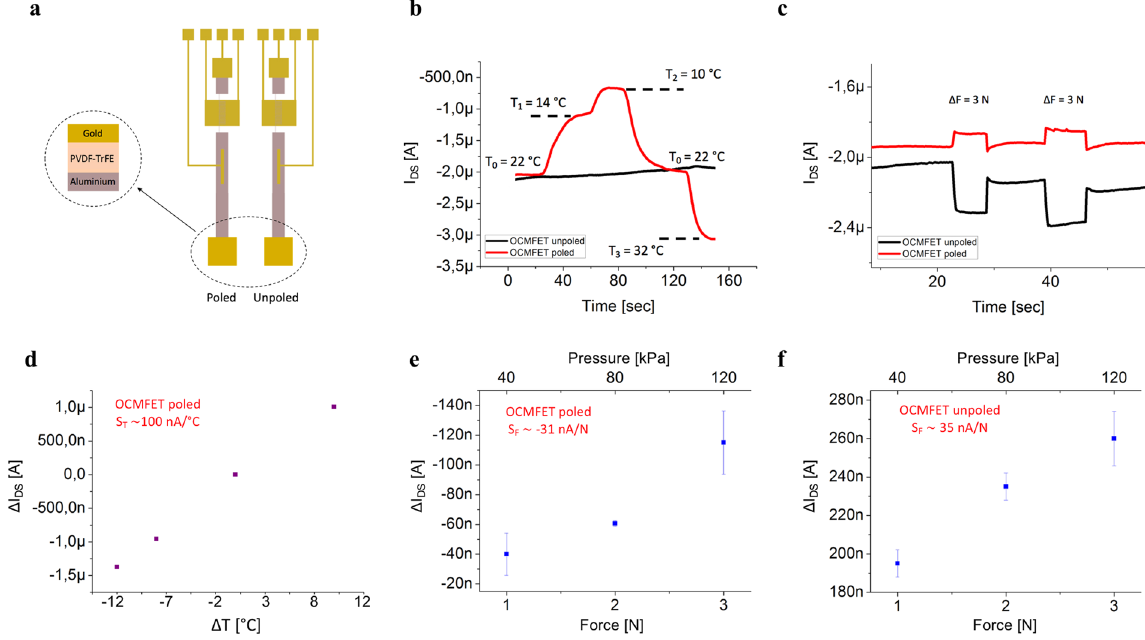
Figure 4. OCMFET pixel for bimodal sensing. ( a ) Schematic representation of OCMFETs with PVDF-TrFE spin-coated onto the sensing area. ( b ) I DS variations upon the application of a thermal stimulus to the sensing area with poled PVDF-TrFE (red curve) and unpoled PVDF-TrFE (black curve). ( c ) Dynamic response of the sensor to the application of force stimuli to the sensing elements. ( d ) Calibration curve and sensitivity of the poled OCMFET in response to thermal stimuli. ( e ) Calibration curve and sensitivity of the poled OCMFETs in response to mechanical stimuli. ( f ) Calibration curve and sensitivity of the unpoled OCMFETs in response to mechanical